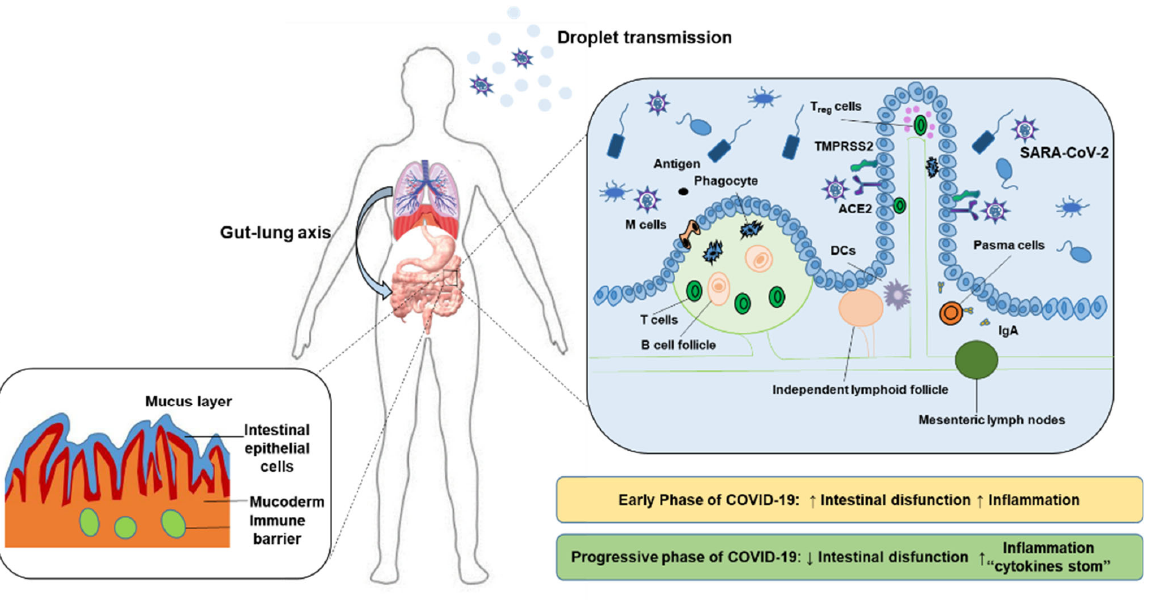
Figure 1. The important immune barrier of human intestine and the mechanism of COVID-19 in ‐ vading human body.